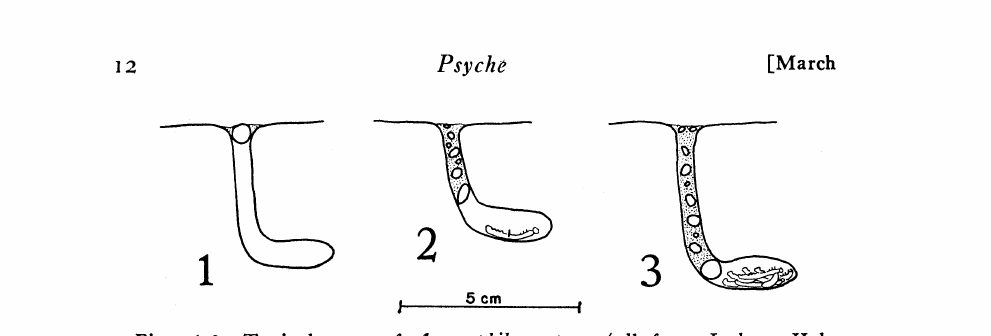
Figs. 1-3. Typical nests of etmmophila azteca (all from Jackson Hole, Wyo.) sho,wing the three types of closures. Fig. 1. No. 2018, an empty nest closed with a single pebble and a small amount o,f sand. Fig. 2. No,. 1993, a nest with a single caterpillar bearing the egg, showing a typical temporary closure. Fig. 3. No. 1996, a fully provisioned nest which had received the final closure. scatters the soil rather widely. In any case it weathers away in a few days, and some .of the soil may be used in